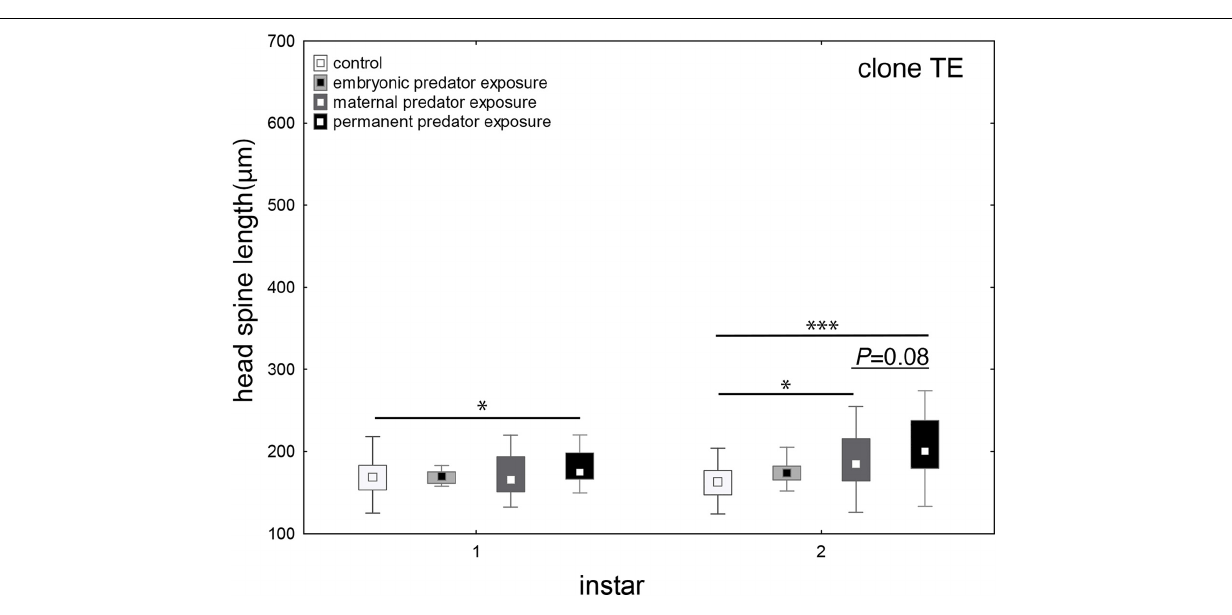
FIGURE 4 | Maternal vs. embryonic predator exposure. When D. lumholtzi embryos are exposed to fish kairomones, defenses are not developed in the first two juvenile instars. When the mothers are exposed to kairomones, head spines in the offspring are significantly larger in the 2nd juvenile instar. When D. lumholtzi is permanently exposed to kairomone, i.e., the mothers and the embryos, head spines of the offspring is significantly increased already in the 1st juvenile instar. Displayed are medians (square), midspread 50% (box) and the 25th percentile (lower whisker); 75th percentile (upper whisker), with outliers (circles). ∗ P ≤ 0.05; ∗∗∗ P ≤ 0.001. ANOVA and Bonferroni post hoc analysis in Supplementary Tables 9 , 10